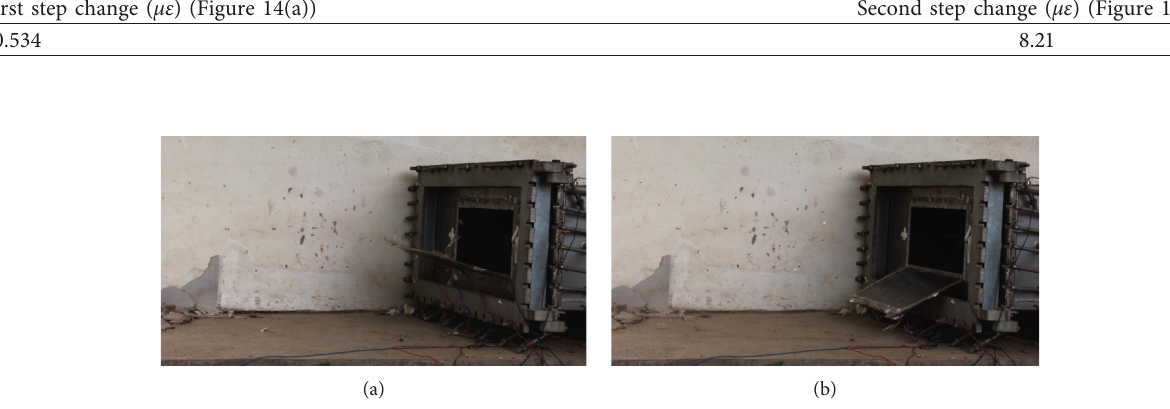
Figure 15: No visible flame in the opening process of the explosion vent in the first test.